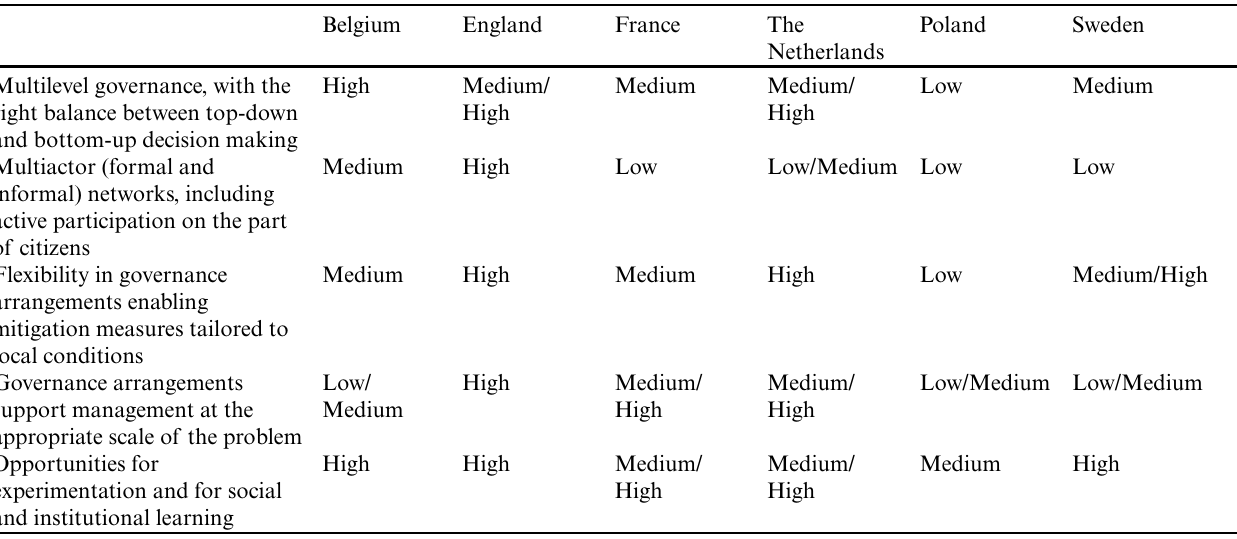
Table 5 . Summary of criteria assessments by country